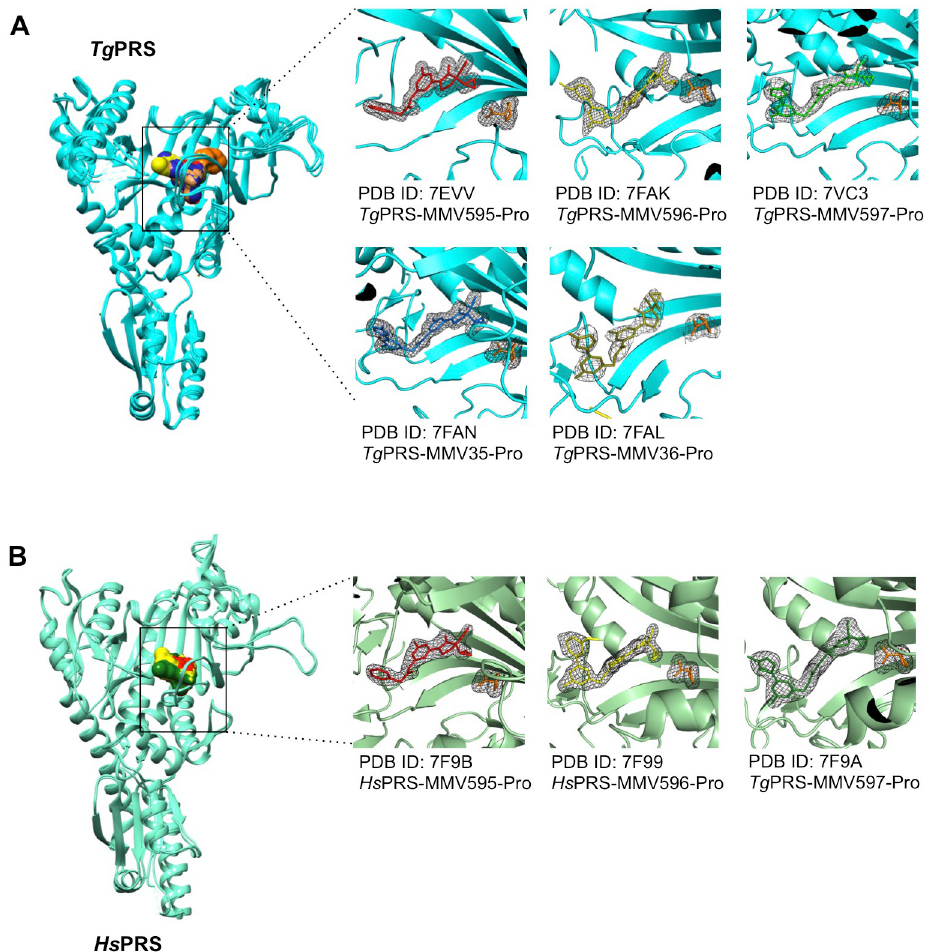
Fig 6. Crystal structure of PRSs in complex with the five compounds. The X-ray structures of the (A) Tg PRSs (cyan) in complex with the five compounds (L95-red; L96-yellow, L97-green, L35-blue and L36-brown). (B) Hs PRS (in pale- green) in complex with the three compounds (L95-red; L96-yellow, L97-green). A composite OMIT difference Fourier map (F o -F c ) generated at respective resolution ( Å ) and contoured at 3 σ showing ATP-mimetics-bound Tg PRS and Hs PRS are